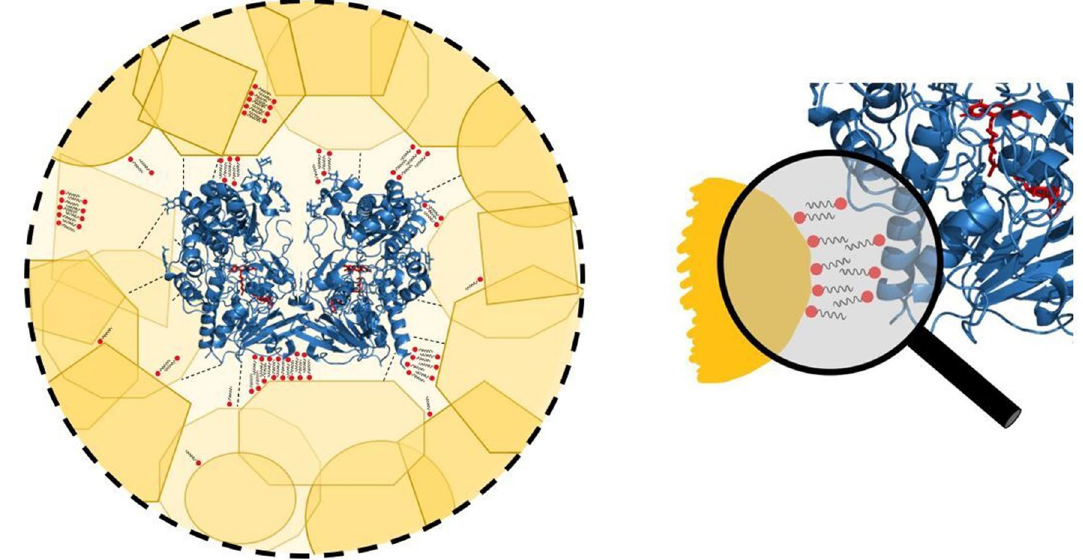
Figure 6. Left: illustration of the interactions which affect a suggested channel opening of the entrapped enzyme in gold with CTAB; right: zoom-in on the CTAB bilayer formed between the gold and GOx (RCSB ID: